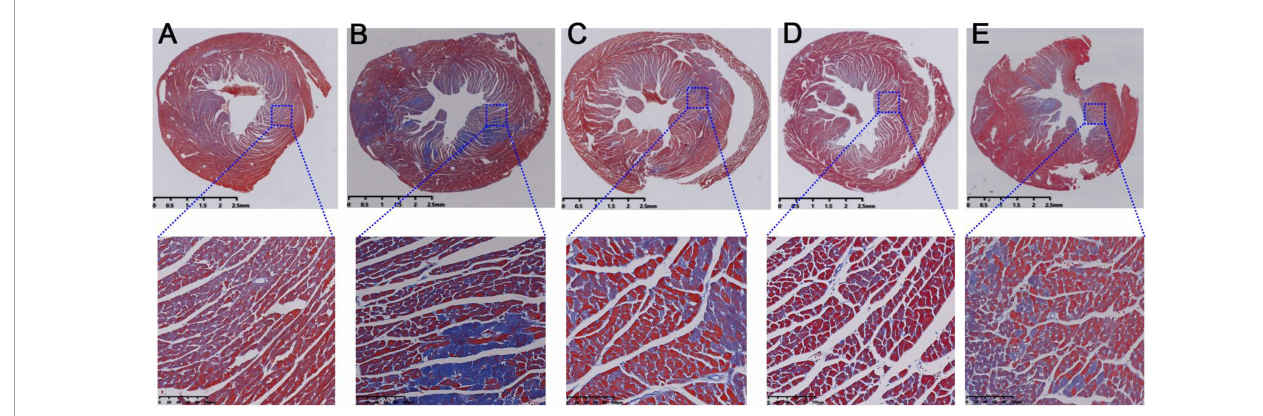
FIGURE4 The Masson staining results of mice heart tissues in control group (A) , model group (B) , rosuvastatin calcium tablets (RSV) group (C) , Allium macrostemon Bge. (AMB) group (D), and Allium chinense G. Don (ACGD) group (E) .